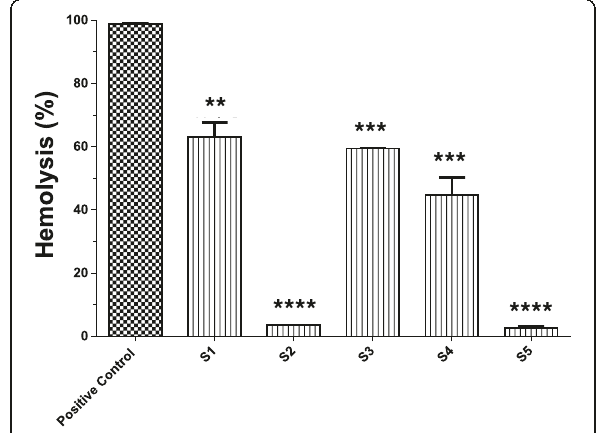
Fig. 3 Effect of fractions S1 - S5 on the classical/lectin hemolytic pathways of complement activation. The fractions (100 μ L in PBS, S1 – A 280 ~ 0.35; S2 – A 280 ~ 0.20; S3 – A 280 ~ 0.17; S4 – A 280 ~ 0.10 and S5 – A 280 ~ 0.16)) were incubated for one hour at 37 °C with normal human serum diluted 1:20 (37.5 μ L) and CFD/Gel solution (12.5 μ L). The positive control was run under the same conditions but in the absence of fractions. The absorbances of supernatants from cells incubated in CFD/Gel buffer (0 % lysis) and lysed in water (100 % lysis) were employed to calculate the percentage of lysis induced by NHS in the absence (positive control) or presence of the fractions (tests). The columns represent means± SEM of an experiment performed in duplicate. ** p < 0.01, *** p < 0.001 and **** p < 0.0001 compared to the positive